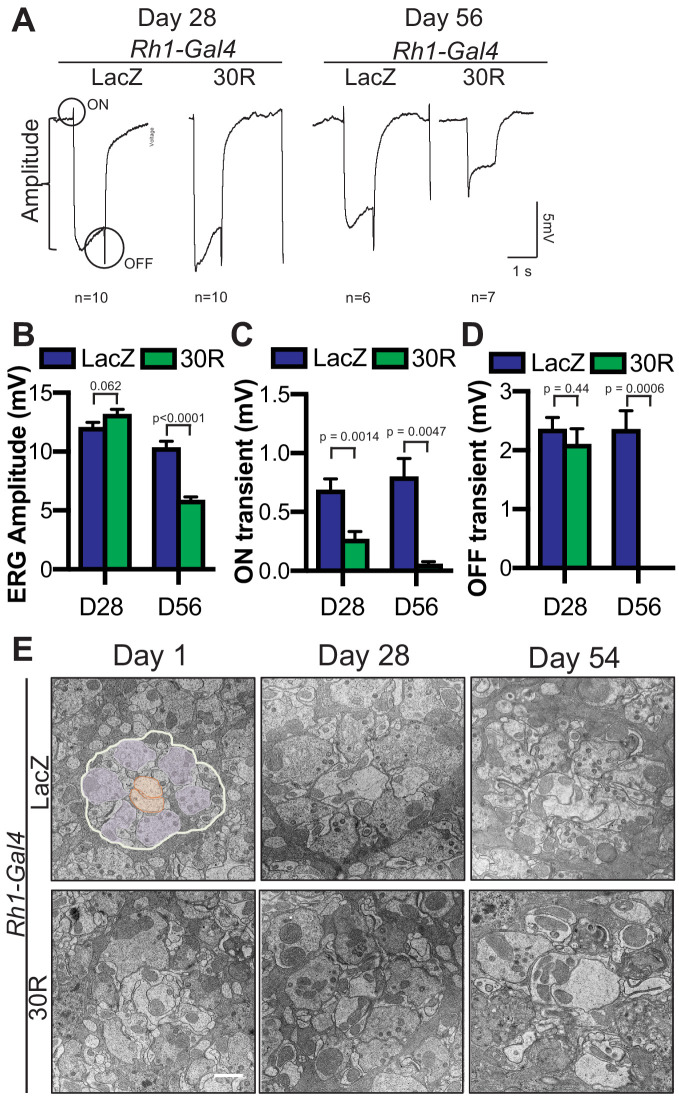
Progressive synapse degeneration in G4C2-expressing photoreceptor neurons.(A) Representative electroretinogram (ERG) of Rhodopsin1-Gal4 driving UAS-LacZ (control) or UAS-30R in adult eyes at Day 28 or Day 56 after eclosion. (B) Quantification of mean ERG amplitude in A. Data are presented as mean ± SEM. Student’s t-test, n = 10, 10, 6, 7. (C) Quantification of mean ON transient amplitude in (A). (D) Quantification of mean OFF transient amplitude in (A). (E) Transmission electron microscopy (TEM) of terminals (synapses) in Rhodopsin1-Gal4 driving UAS-LacZ (control) or UAS-30R adult eyes at Day 1, Day 28, and Day 54 after eclosion. For the Day 1 control image, presynaptic terminals are pseudocolored in purple and post-synaptic terminals are pseudocolored in orange. Scale bar = 1 µm.